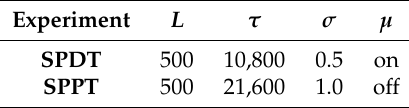
Table 1. Configuration of the random forcing (RF) tuning parameters for the experiment using stochastically perturbed dynamical tendency (SPDT) and stochastically perturbed physical tendency (SPPT): L is the horizontal correlation length scale (in km), τ the de-correlation time scale (in s), σ the standard deviation, and µ the tapering